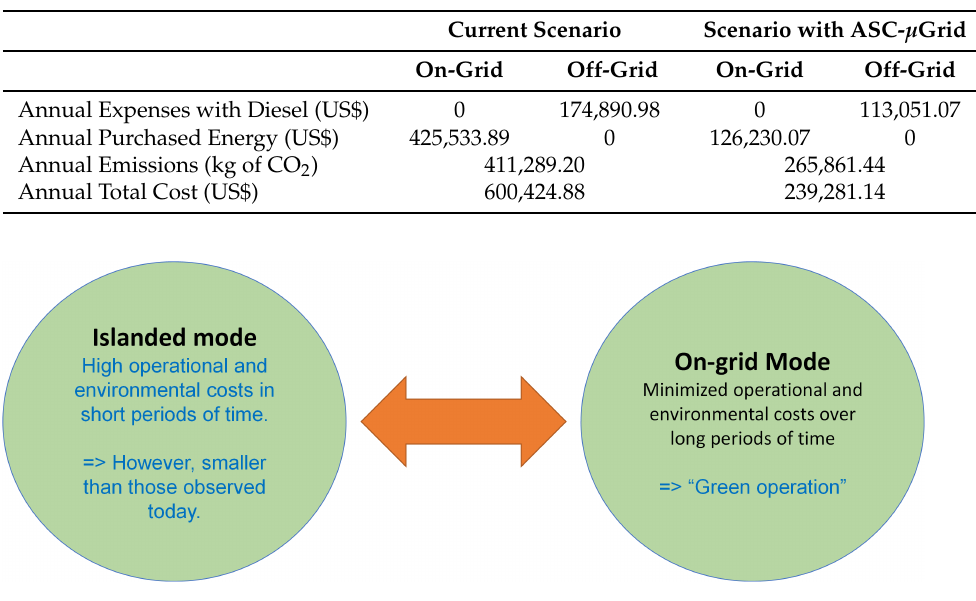
Figure 2. Characteristics and benefits of ASC- µ Grid operation scenarios.